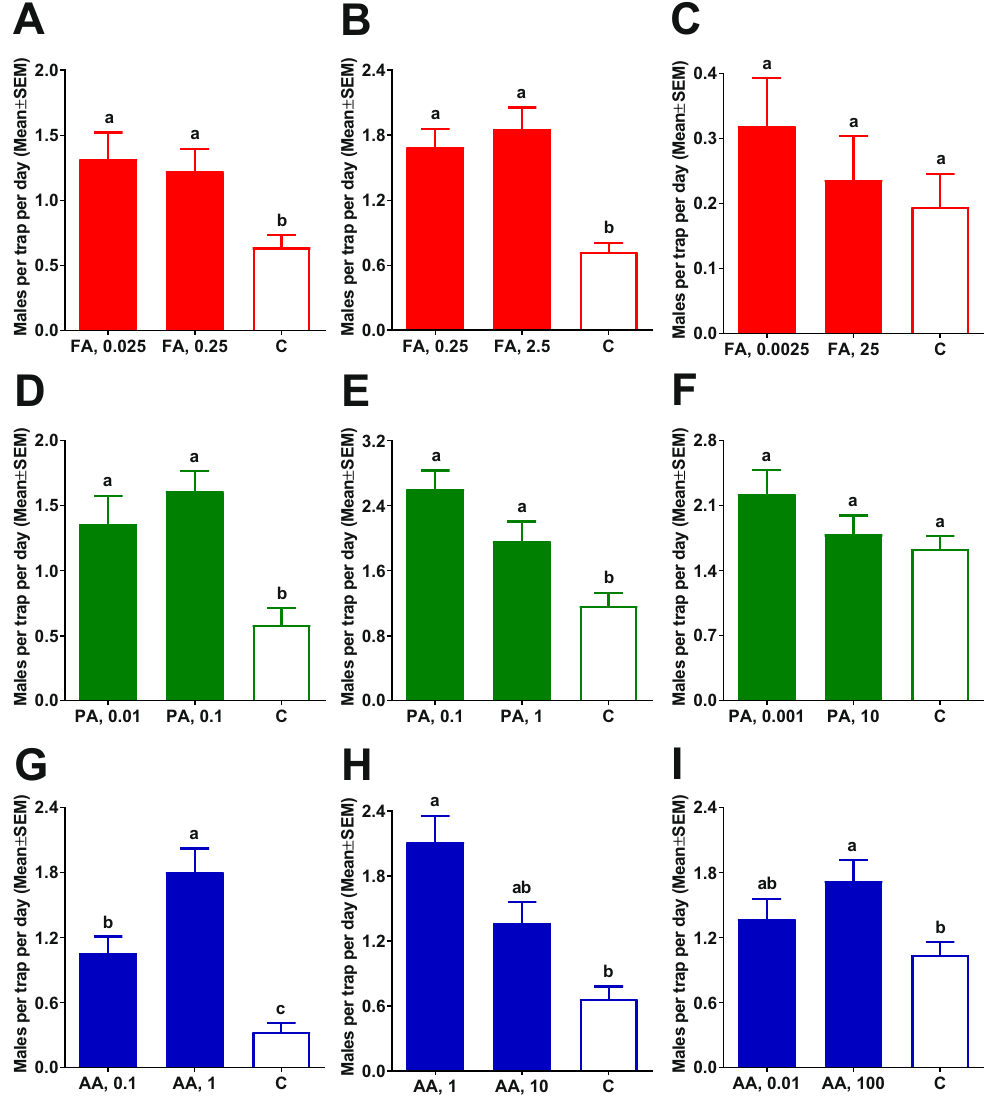
Figure 4. Field evaluations of ACP attractants as potential lures. Male captures in traps baited with formic acid (FA) at ( A ) 0.025 and 0.25 µ g; ( B ) 0.25 and 2.5 µ g; ( C ) 0.0025 and 25 µ g; propionic acid (PA) at ( D ) 0.01 and 0.1 µ g; ( E ) 0.1 and 1 µ g; and ( F ) 0.001 and 10 µ g; and acetic acid (AA) at ( G ) 0.1 and 1 µ g; ( H ) 1 and 10 µ g; and ( I ) 0.01 and 100 µ g were compared with their respective controls. Data were analyzed by Kruskal-Wallis, followed by Dunn’s multiple comparison tests. In each test, bars labeled with the same letters are not significantly